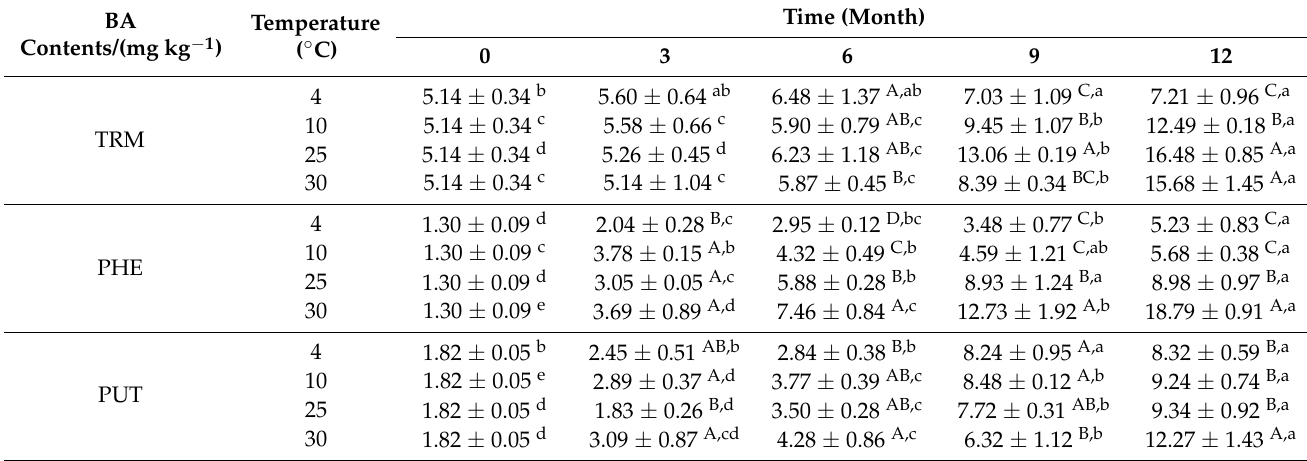
Table 2. Changes of BAs in canned sardine during storage at different